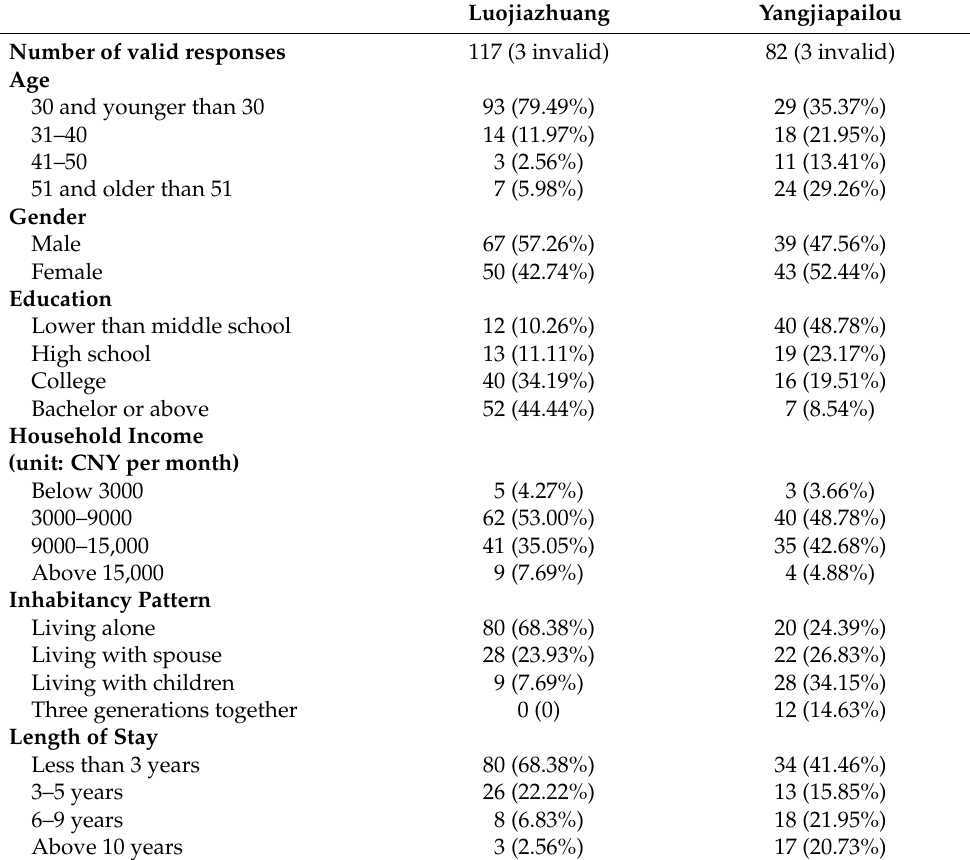
Table 3. Basic information of respondents in Luojiazhuang and